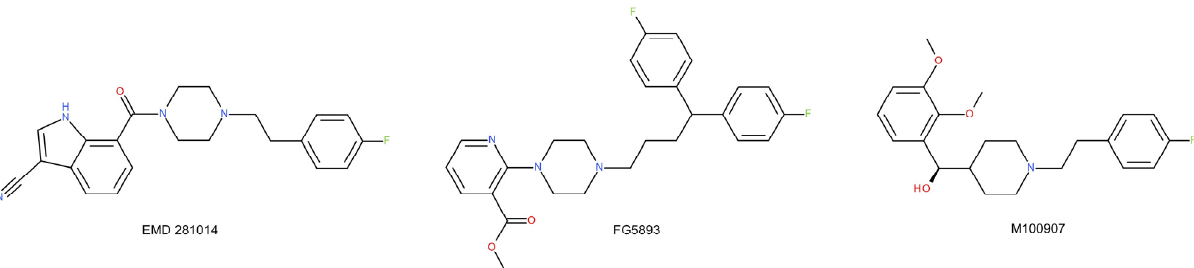
Figure 5. 5-HT 2A receptor antagonists: EMD 281014, FG5893 and M100907.